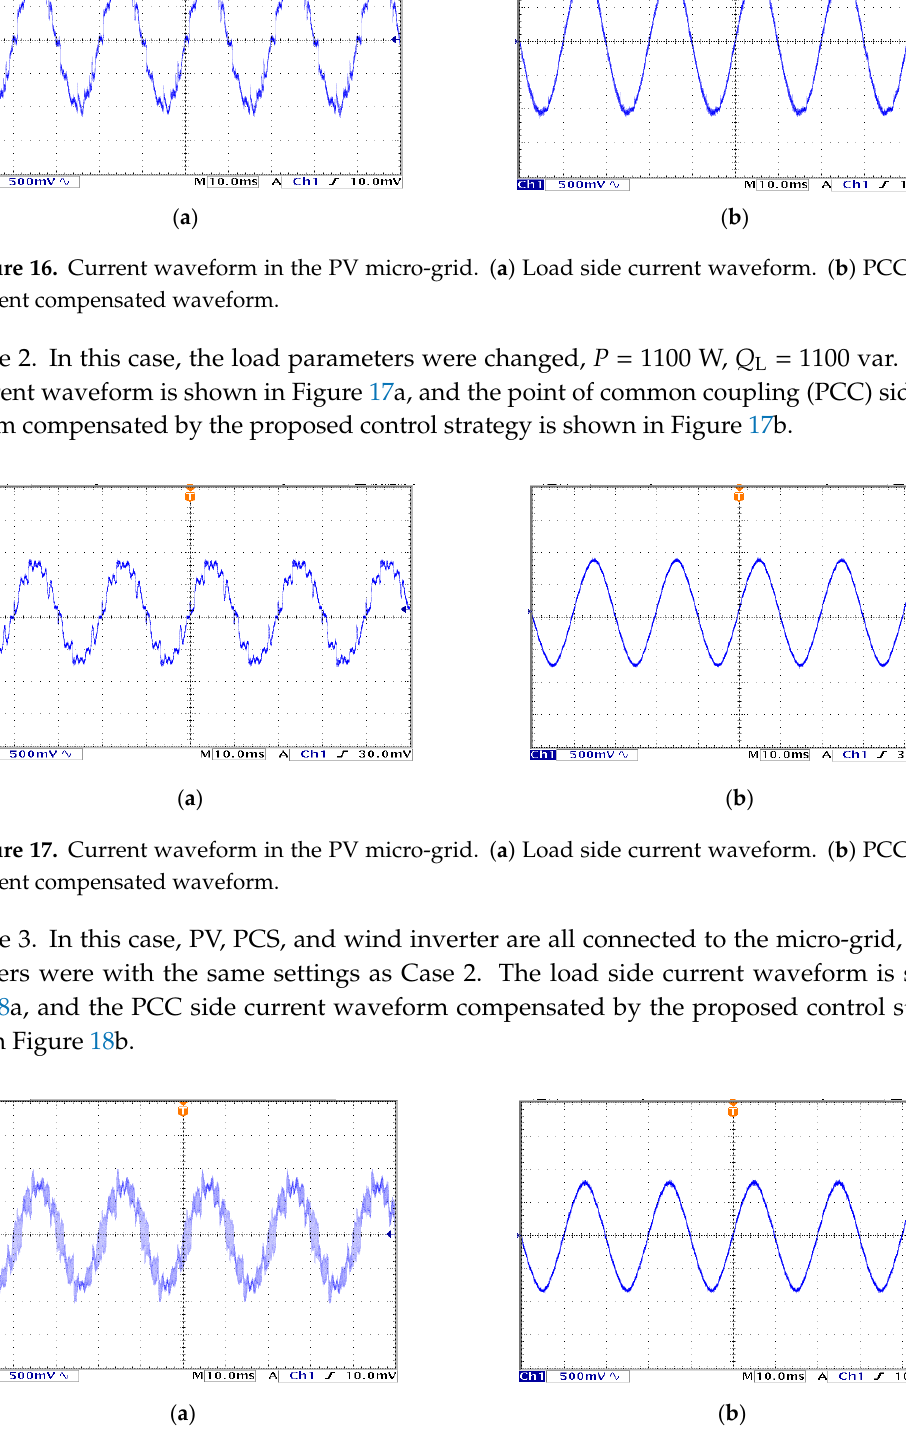
Figure 18. Current waveform in the hybrid micro-grid. ( a ) Load side current waveform. ( b ) PCC side current compensated waveform.